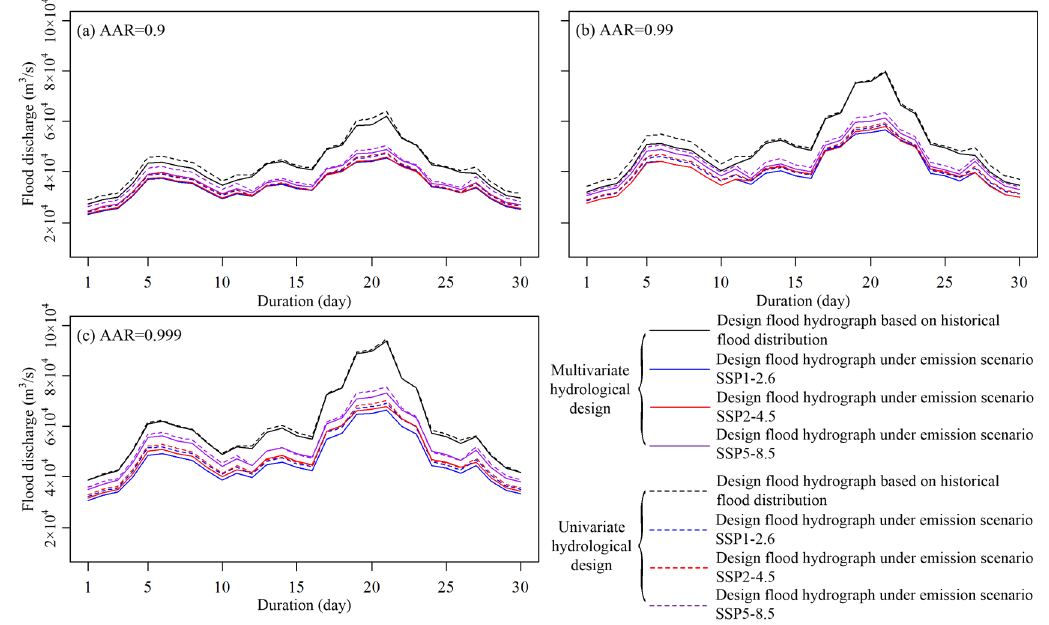
Figure 8. Dam-site design hydrographs associated with Kendall exceedance probability for the TGR. Panels ( a – c ) display the results for design levels with the AARs of 0.9, 0.99 and 0.999, respectively.